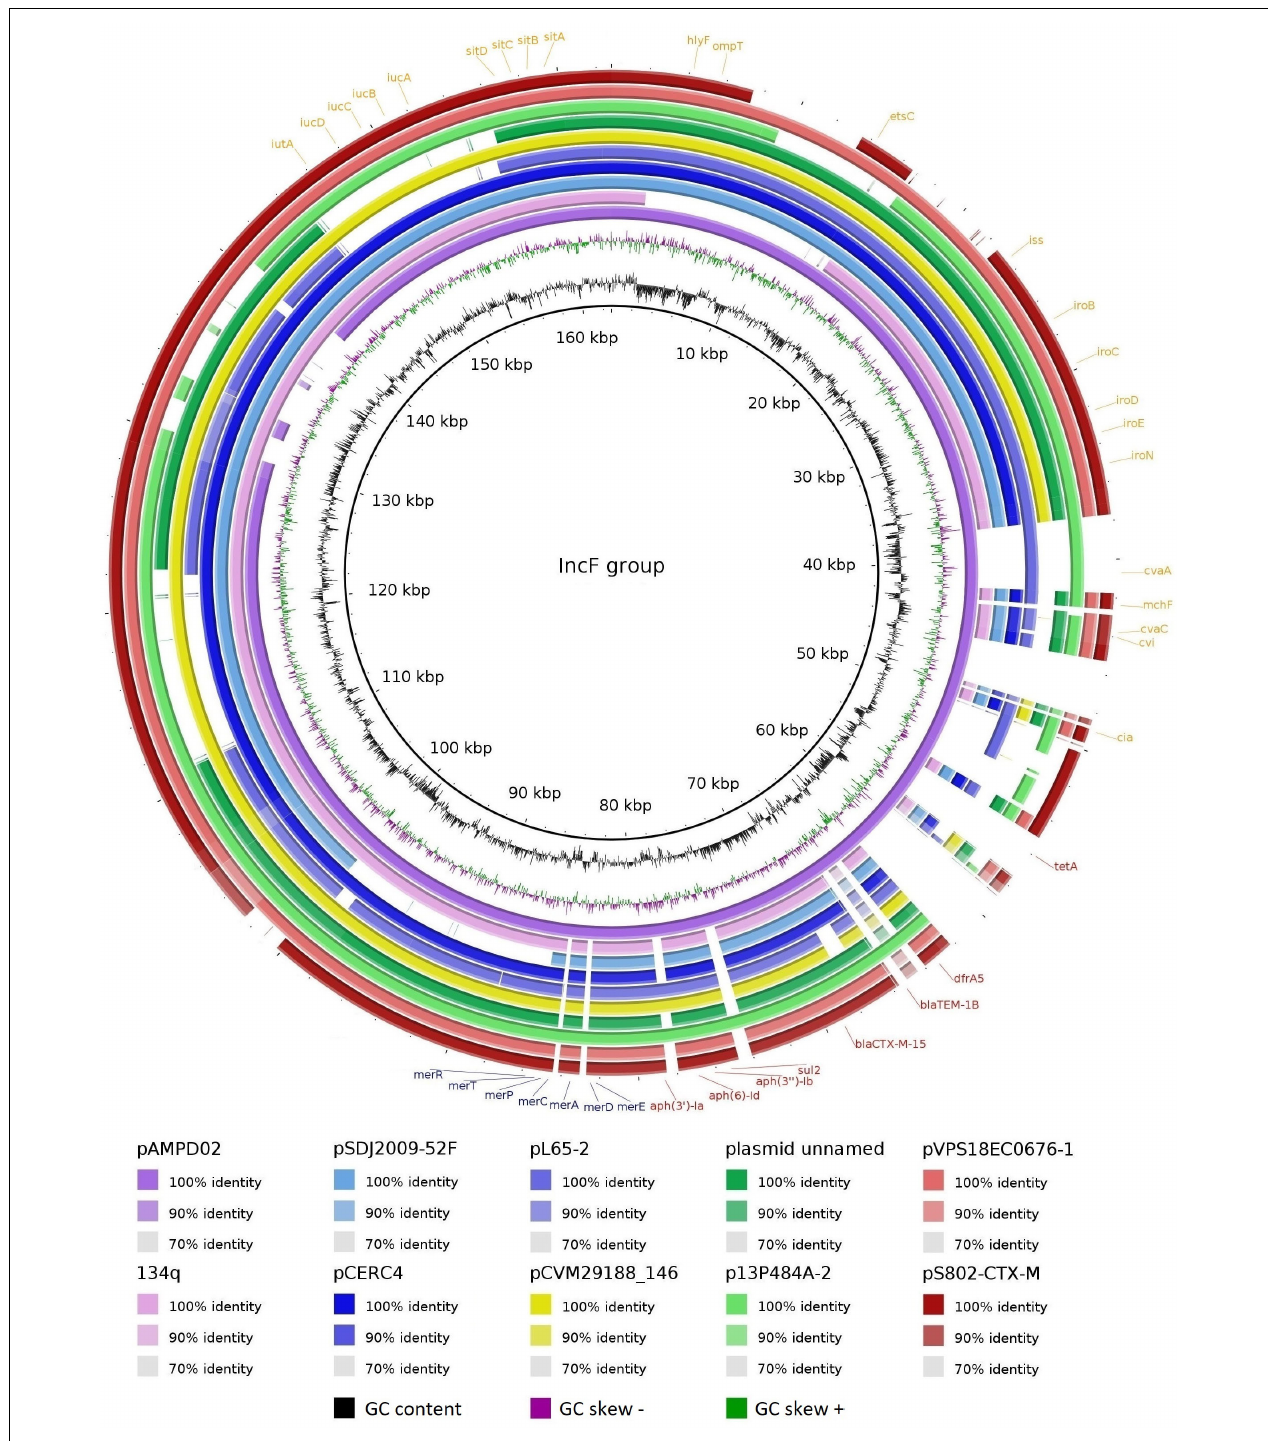
FIGURE 5 | Comparison between IncF plasmids. Plasmids of E. coli strains: pAMPD02 (GenBank: CP058310.1) from a giant panda in China; 134q (GenBank: CP023363.1) from a canine in Scotland; pSDJ2009-52F (GenBank: MH195200.1) and pCERC4 (GenBank: KU578032.1) from a human in Australia; plasmid unnamed (GenBank: CP027485.1) from a human in the United States; pL65-2 (GenBank: CP034739.1) from a goose in China; p13P484A-2 (GenBank: CP019282.1) from a pig in China; pVPS18EC0676-1 (GenBank: CP063726.1) from veal in the United States; pS802-CTX-M (GenBank: MW495061.1) from soil in Brazil. Plasmid of Salmonella Kentucky: pCVM29188_146 (GenBank: CP001122.1) from poultry in the United States. Matches with less than 70% identity and no matches appear as blank spaces. Resistance genes to antimicrobials and metals are indicated in red and blue, respectively, whereas virulence genes are indicated in